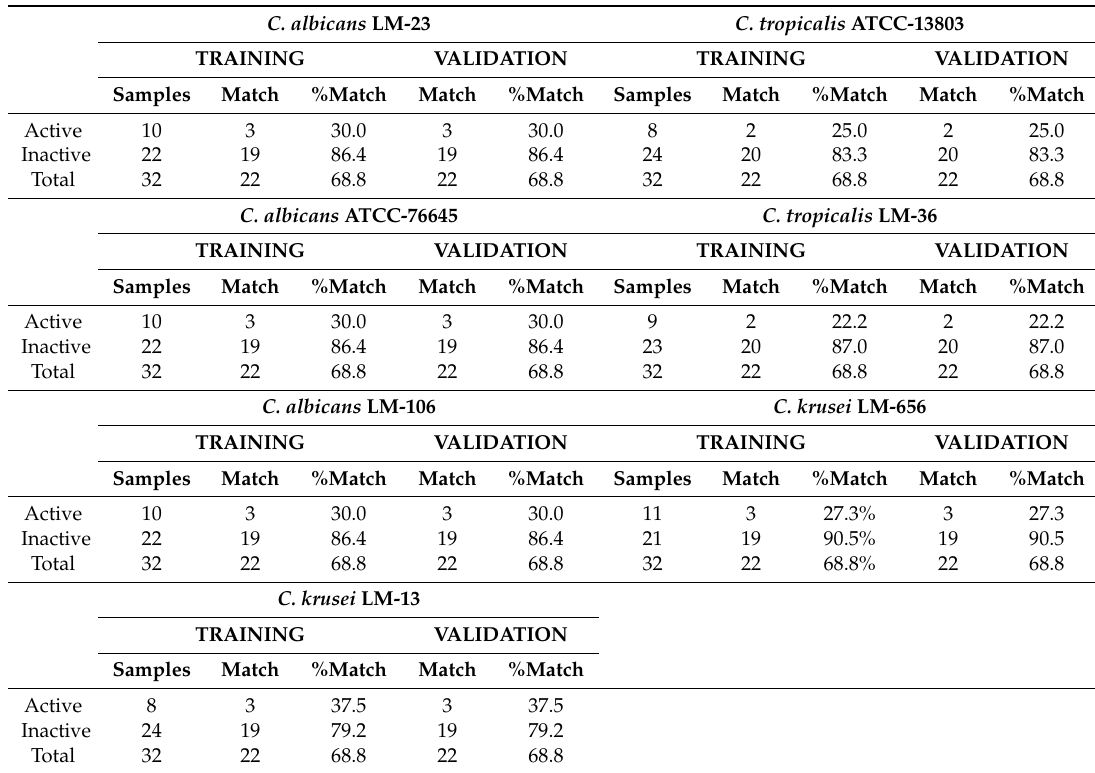
Table 4. Summary of training, internal cross-validation, test results and corresponding match results which were obtained using a leave-one out validation method in KNIME of the total set of 32 haloamides subjected to antifungal